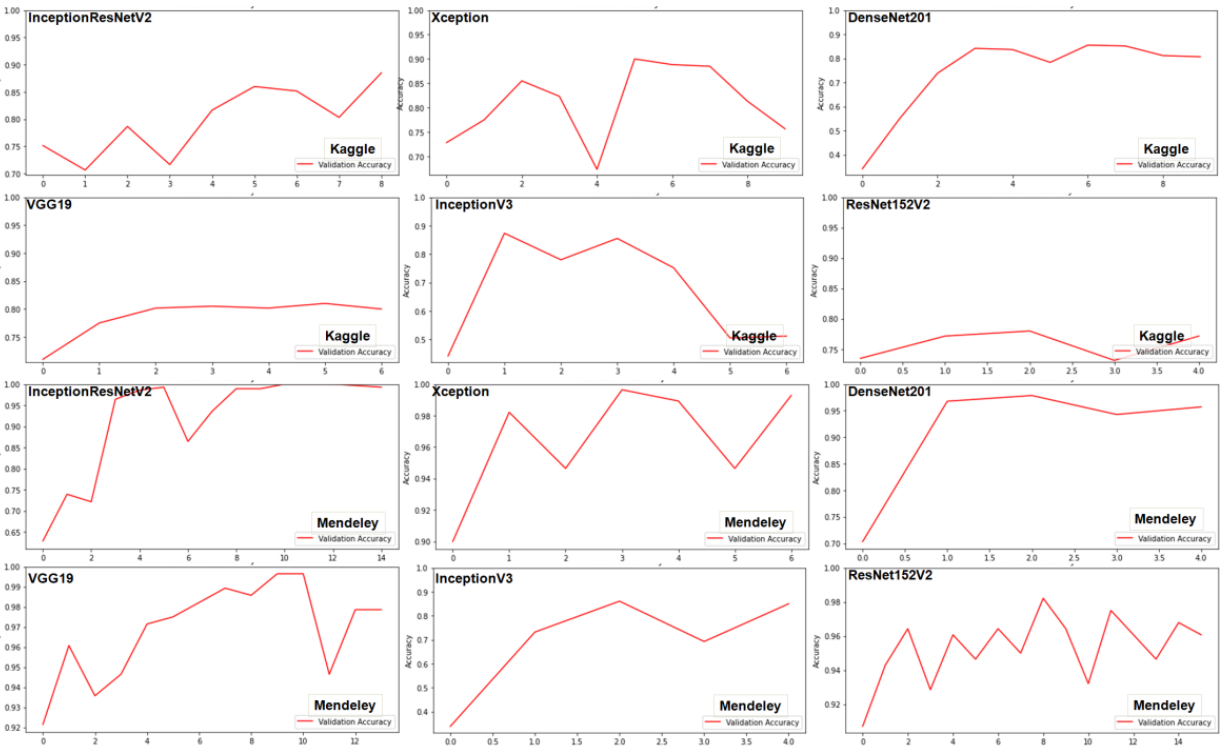
Figure 7. Validation accuracy versus number of epochs.